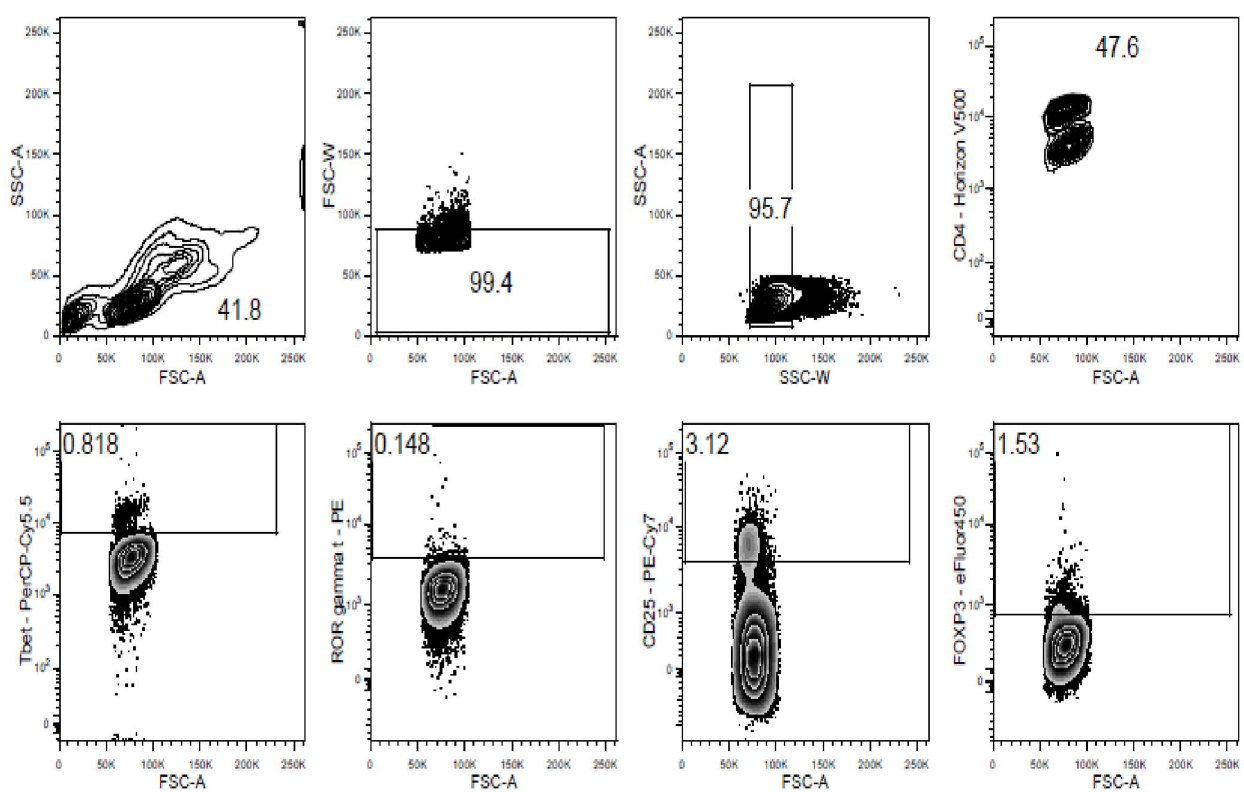
Fig. 1. CBMC of neonates from filaria infected and uninfected mothers were isolated, fixed and stained with fluorescently labeled antibodies specific to surface markers (CD4, CD25) and intracellular transcription factors (FOXP3, Tbet, ROR c T). Here we show an example of the gating strategy used for the identification of CD4 + Tbet + , CD4 + ROR c T + and CD4 + CD25 hi FOXP3 + Tcells. Cells were first gated for lymphocytes (FSC-A vs SSC-A) and for singlets (FSC-A vs FSC-W and SSC-w vs SSC-A). Next, CD4 + cells were selected, to which Tbet, RORgt, CD25 and FOXP3 gating was applied. By combining these gates, Tbet + RORgt-FOXP3-, RORgt + Tbet-FOXP3- and CD25hiFOXP3 + Tbet-RORgt- CD4 + T cells could be